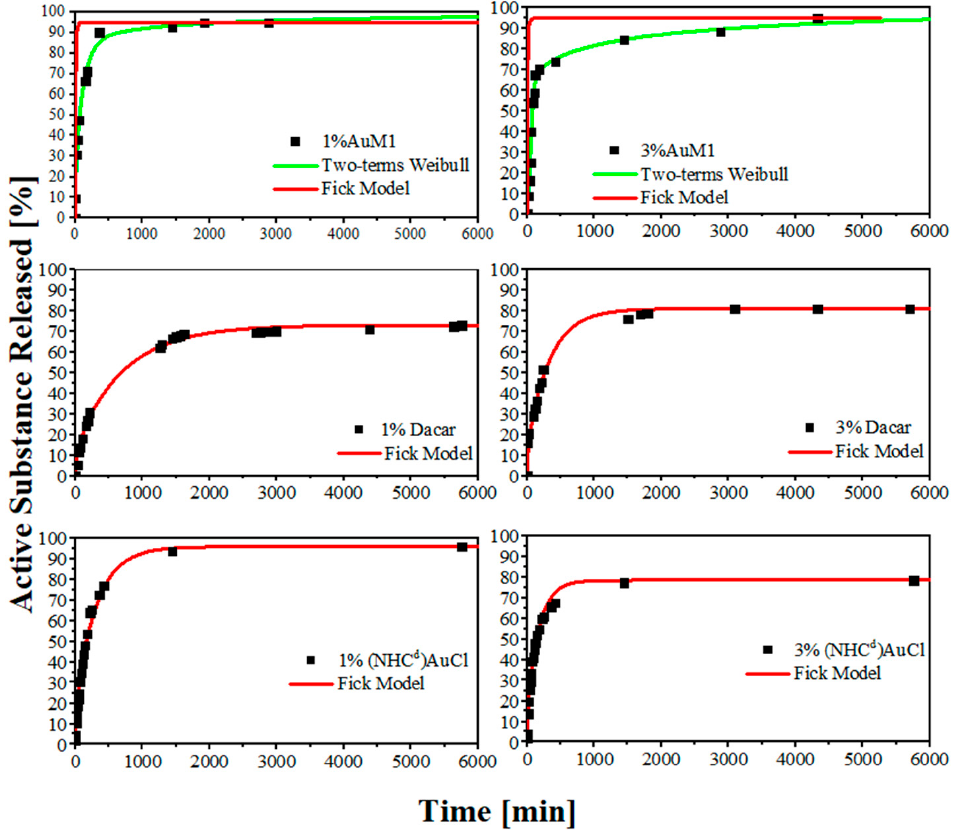
Figure 6. Release curve of the electrospun membranes.